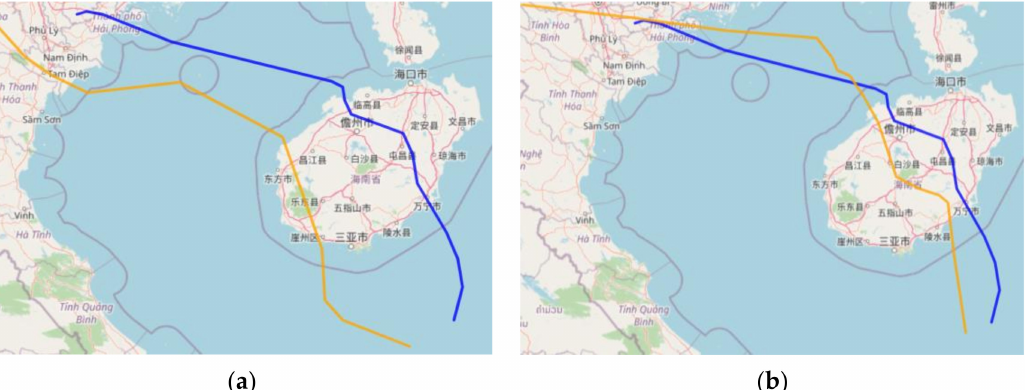
Figure 7. Comparison of the predicted path of Typhoon “Lionrock” using two models, where the blue path indicates the actual path of the typhoon and the orange path indicates the path predicted by different models. ( a ) The comparison of the true path and predicted path using the LSTM model for prediction, ( b ) the comparison of the true path and predicted path using the C-LSTM model for prediction. p.s. The left side of the ocean represents Vietnam, where the non-English text indicates different cities in Vietnam; the right side of the ocean represents Hainan, China, where the non-English text indicates different cities in